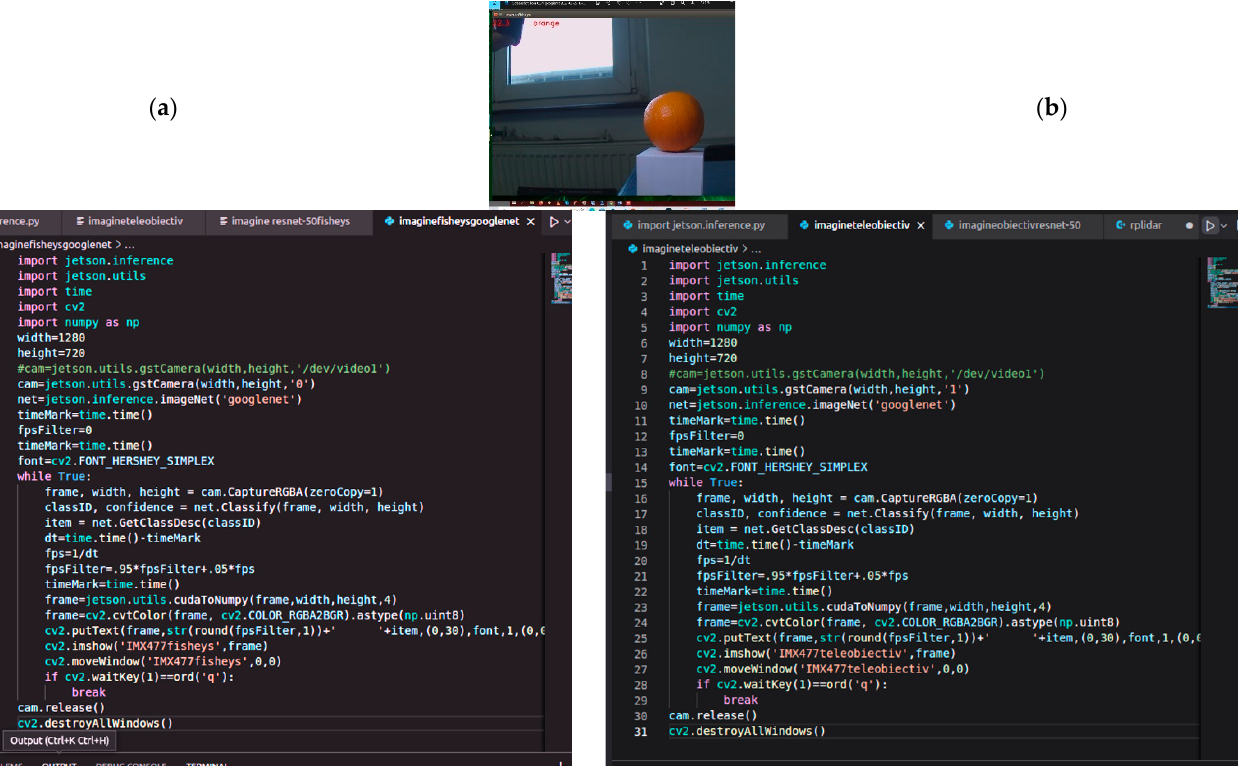
Figure 11. Distance measurement and object recognition by HQ Camera and RPLIDAR scanner. ( a ) 0.50 m distance screenshot, 6 mm fisheye lens, GoogLeNet database; ( b ) 1.50 m distance screenshot, 16 mm telephoto lens, GoogLeNet database. (c)